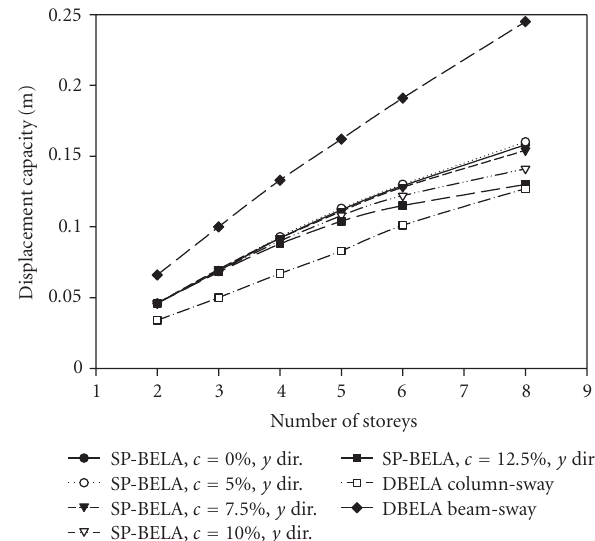
Figure 12: Mean yield displacement capacity versus number of storeys for the beam- and column-sway cases of DBELA compared with each of the SP-BELA design categories in the x direction.